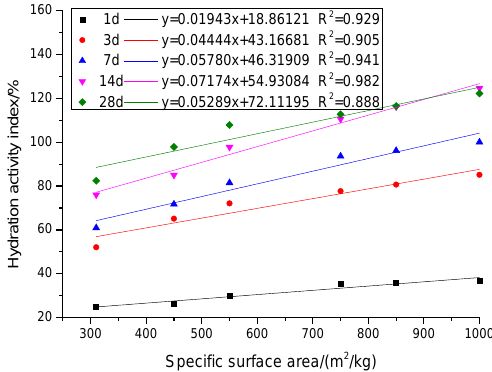
Figure 4. Relationship between SSA and HAI of GGBS.